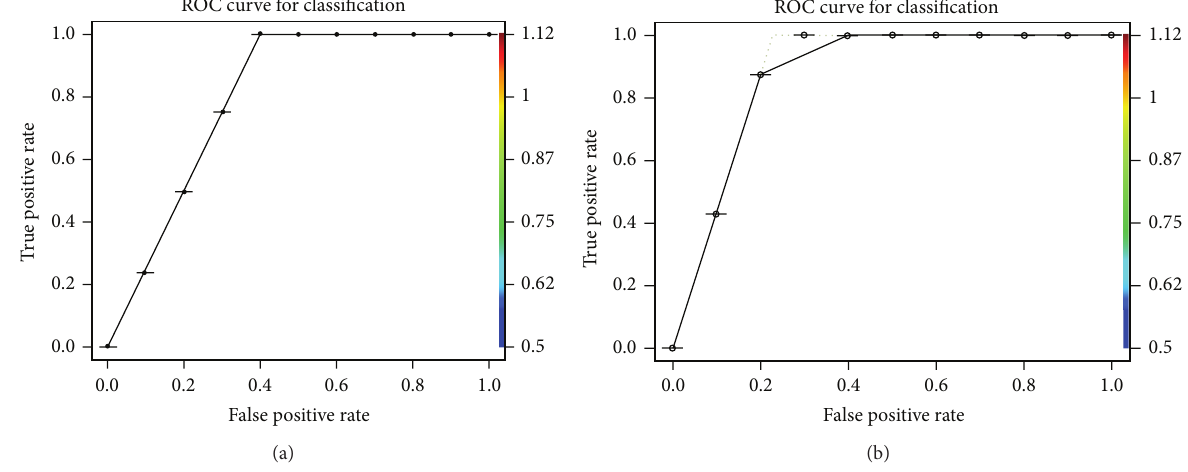
Figure 5: (a) ROC curve for na¨ıve Bayes classifier. (b) ROC curve for